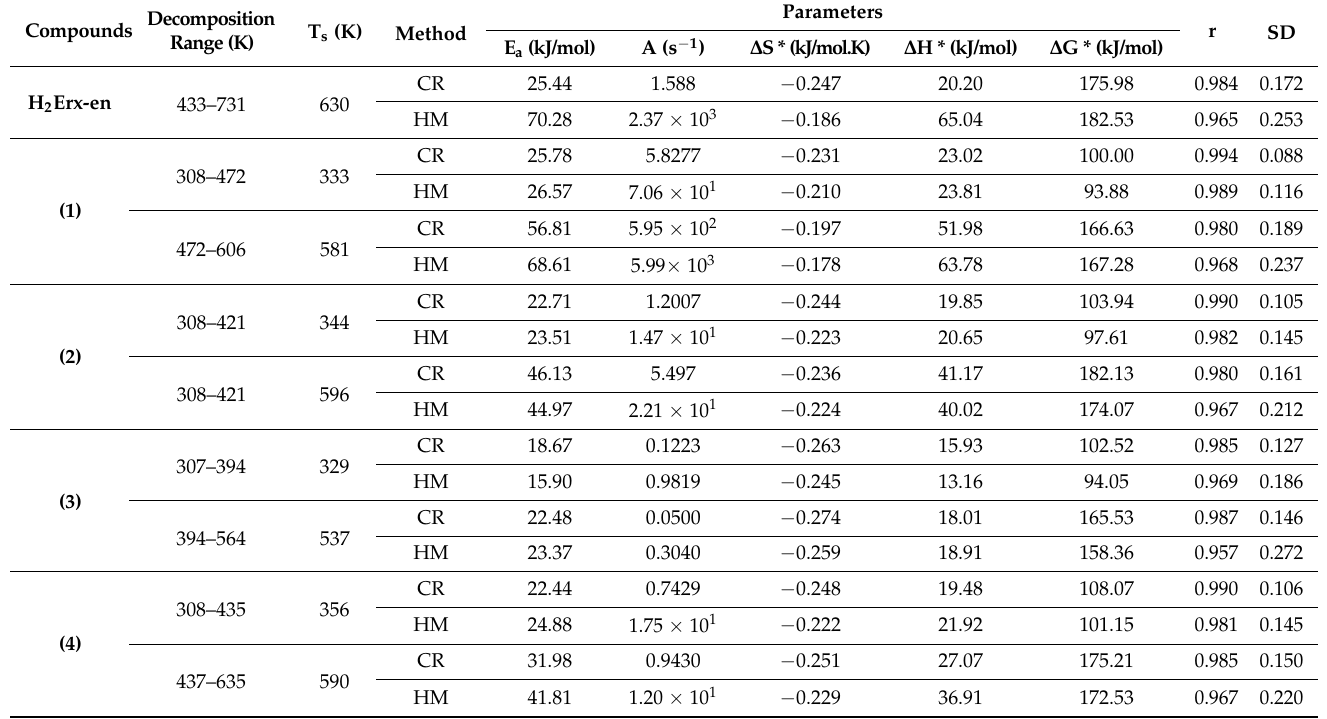
Table 6. Thermal behavior and kinetic parameters determined using Coats–Redfern (CR) and Horowitz–Metzger (HM) methods operated for H 2 Erx-en and its metal complexes. Decomposition Compounds Range